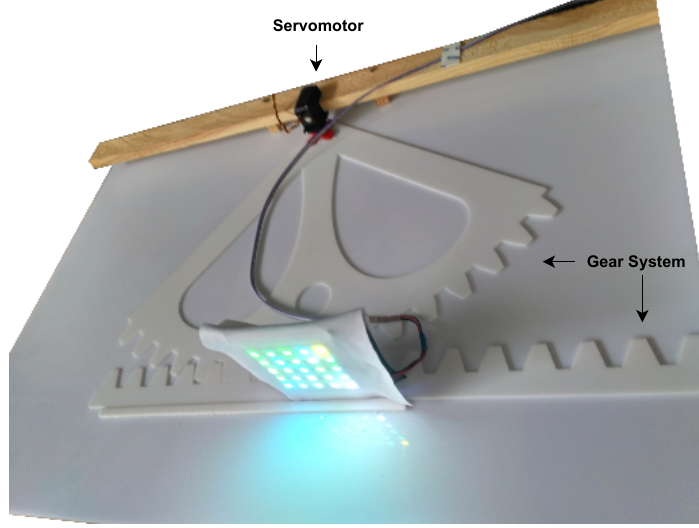
Figure 8. Mechanical system of test.